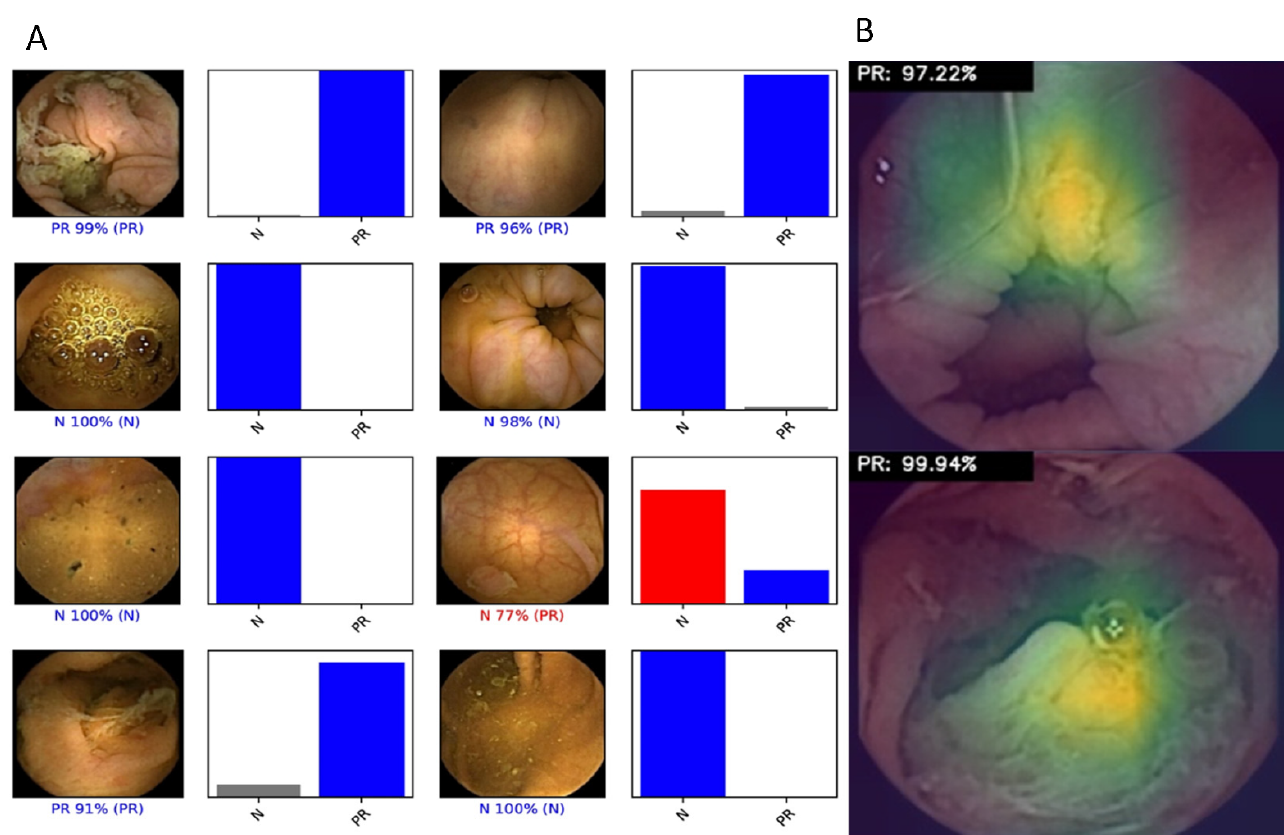
Figure 2. Heatmaps ( A ) and output ( B ) obtained from the application of the convolutional neural network. ( A ) Examples of heatmaps showing CCE features of protruding lesions as identified by the CNN. ( B ) The bars represent the probability estimated by the